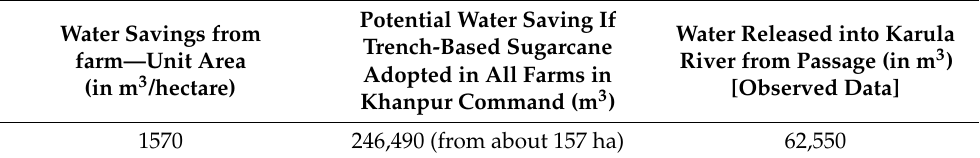
Table 3. The current gains due to pilot project